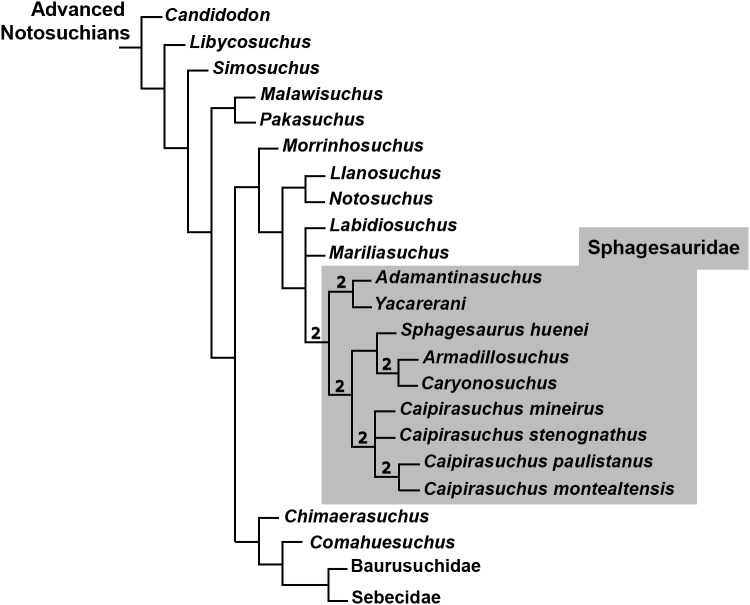
Phylogenetic position of C. mineirus.Reduced strict consensus after pruning Pehuenchesuchus, Microsuchus, Neuquensuchus, Coringasuchus, and Pabwehshi.